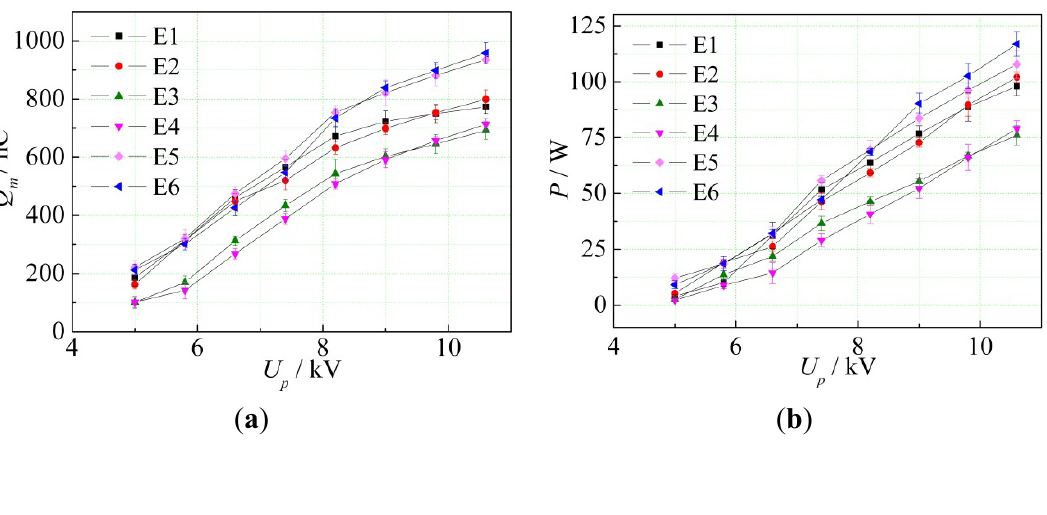
and discharge power P obtained for E1–E6 m